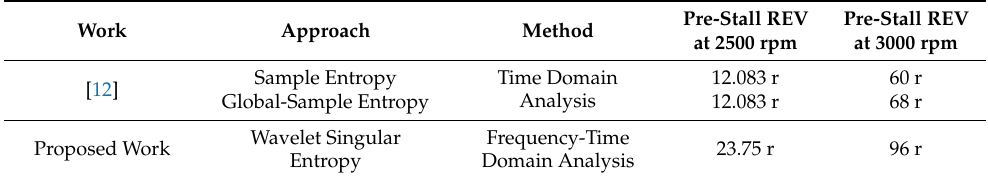
Table 3. The comparison of the proposed method and related